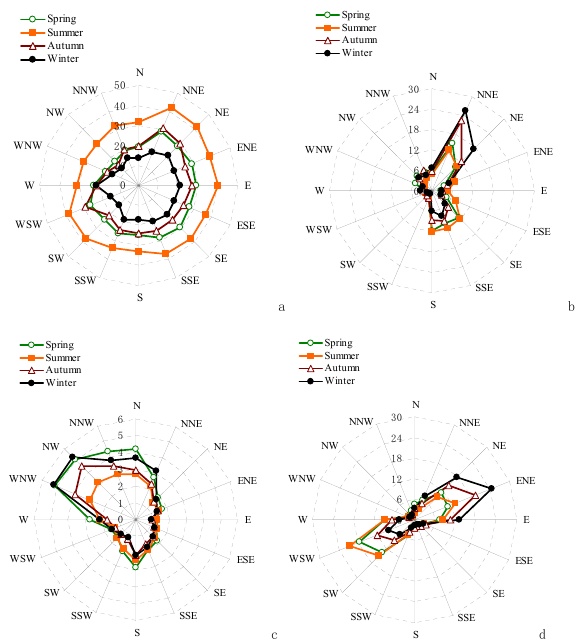
Fig.5 Seasonal average NH 3 concentrations at CMA (a), wind frequency at CMA (b), wind speed at 3 Fig. 5. Seasonal average NH 3 concentrations at CMA (a) , wind CMA (c) and wind frequency at SDZ (d) distributions in different wind sectors during 2009-2010. frequency at CMA (b) , wind speed at CMA (c) and wind frequency at SDZ (d) distributions in different wind direction sectors during 2009–2010.